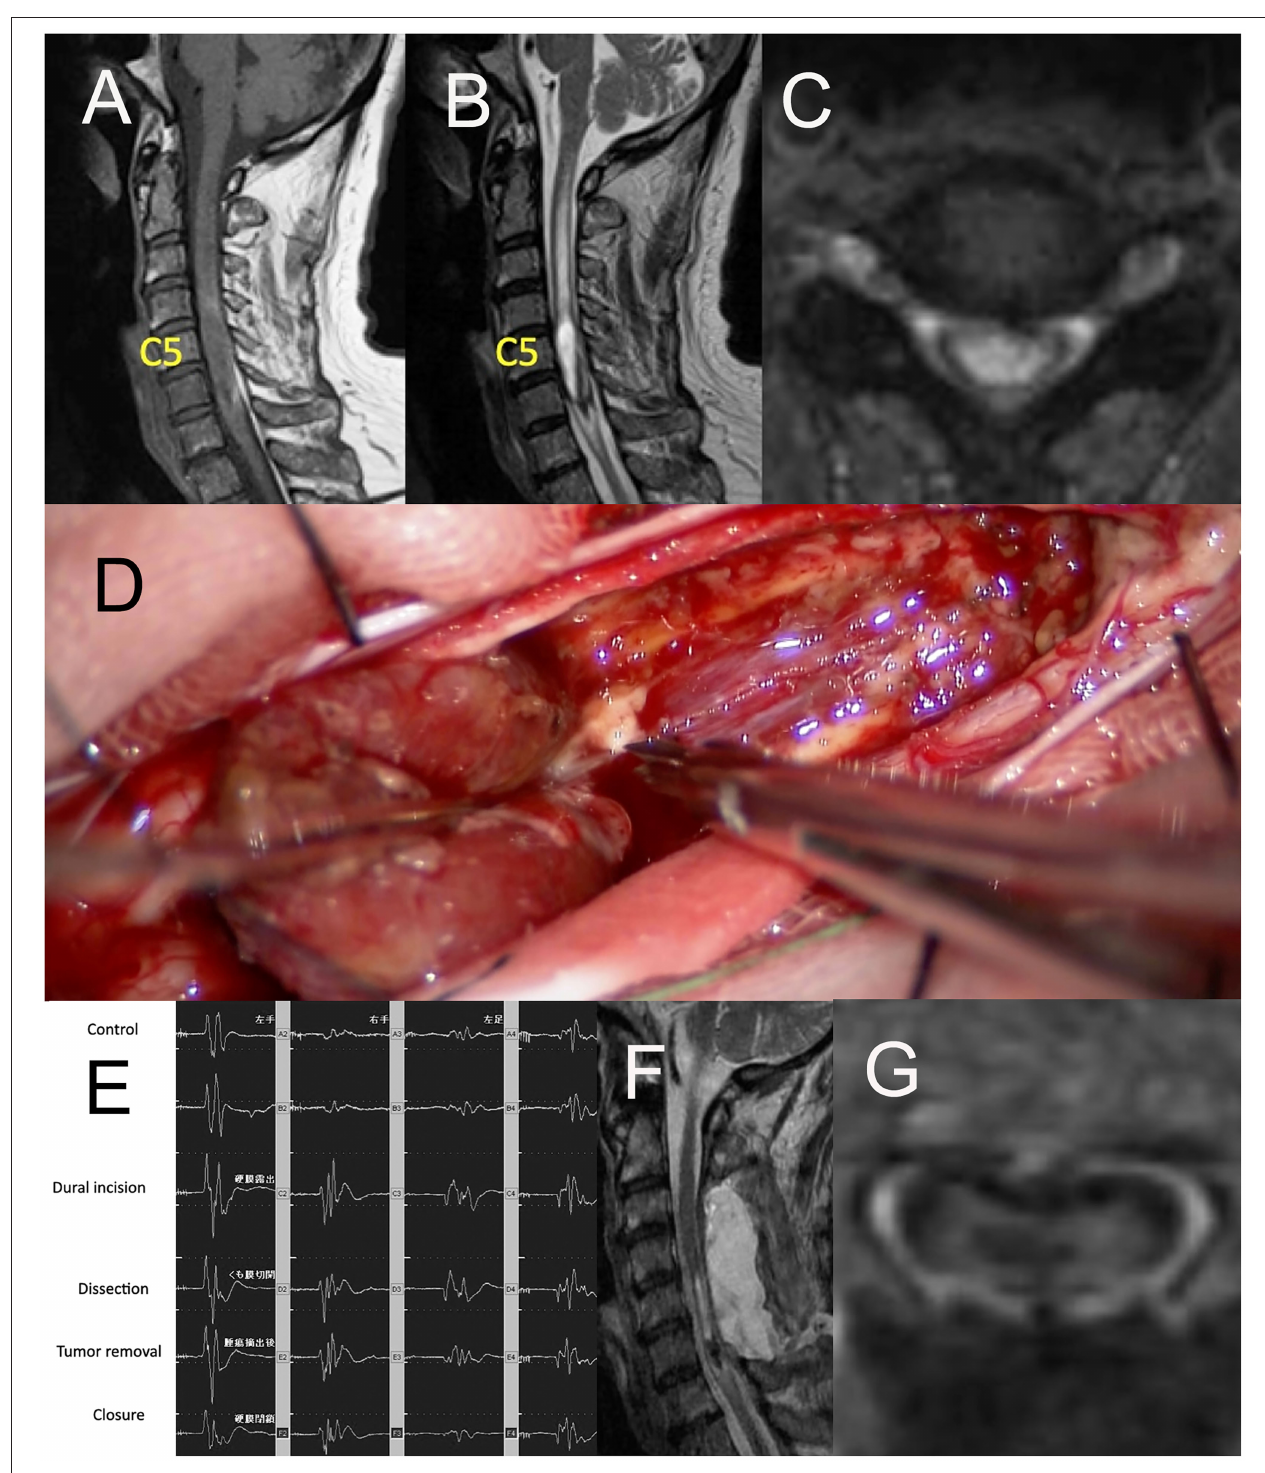
FIGURE 2 | (A) Sagittal image of preoperative Gd-enhanced T1WI of MRI, (B) the axial image of preoperative T2WI of MRI, (C) the axial image of preoperative Gd-enhanced T1WI of MRI, (D) intraoperative photograph of tumor resection through midline myelotomy by posterior approach, (E) Ratio motor-evoked potential (MEP) of both UE and LE ranged from 91 to 108%, (F) Sagittal image of postoperative Gd-enhanced T1WI of MRI, (G) the axial image of postoperative Gd-enhanced T1WI of MRI. Gd, gadolinium; TIWI, T1-weighted image; MRI, magnetic resonance imaging; T2WI, T2-weighted image; UE, upper extremity; LE, lower extremity.